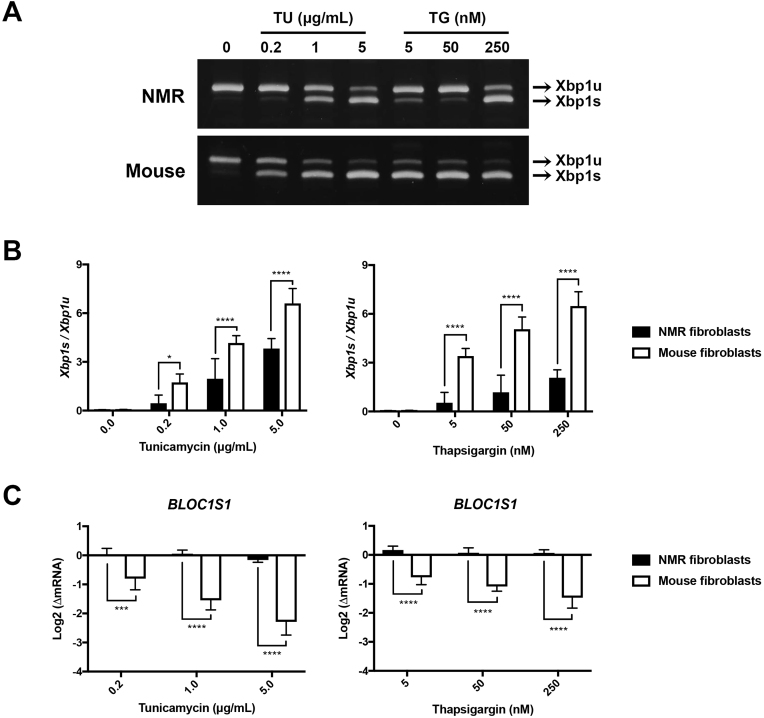
Xbp1 splicing and RIDD degradation in the NMR and mouse kidney fibroblasts in response to TU (6 h) and TG (4 h).(A) Representative images of the RT-PCR products of Xbp1s and Xbp1u on 6% TBE gels. The graphs in (B) show the mean ± S.D. of Xbp1s-to-Xbp1u ratios in the NMR and mouse fibroblasts as a response to increasing concentrations of TU (left) or TG (right). n = 5 pairs; ∗P < 0.05; ∗∗∗∗P < 0.0001; two-way ANOVA tests, Sidak’s multiple comparisons tests. (C) Bloc1s1 degradation measured by RT-qPCR. Data were presented as mean ± S.D. of log-transformed mRNA fold change compared to the basal-level expression in untreated controls. n = 5 pairs; ∗P < 0.05, ∗∗∗P < 0.001, ∗∗∗∗P < 0.0001; two-way ANOVA tests, Sidak’s multiple comparisons tests.